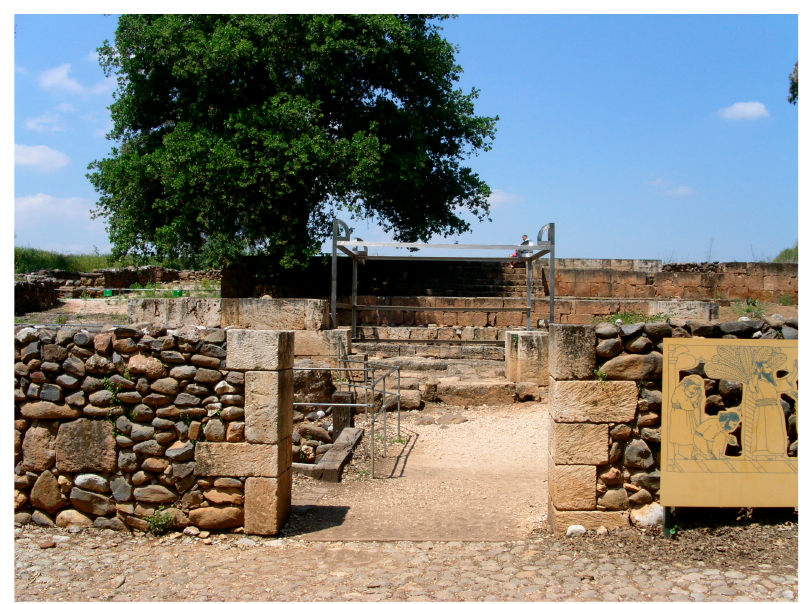
Figure 2. A photograph of the Tel Dan (reconstructed) cultic complex, with the platform at the background (photographed by the